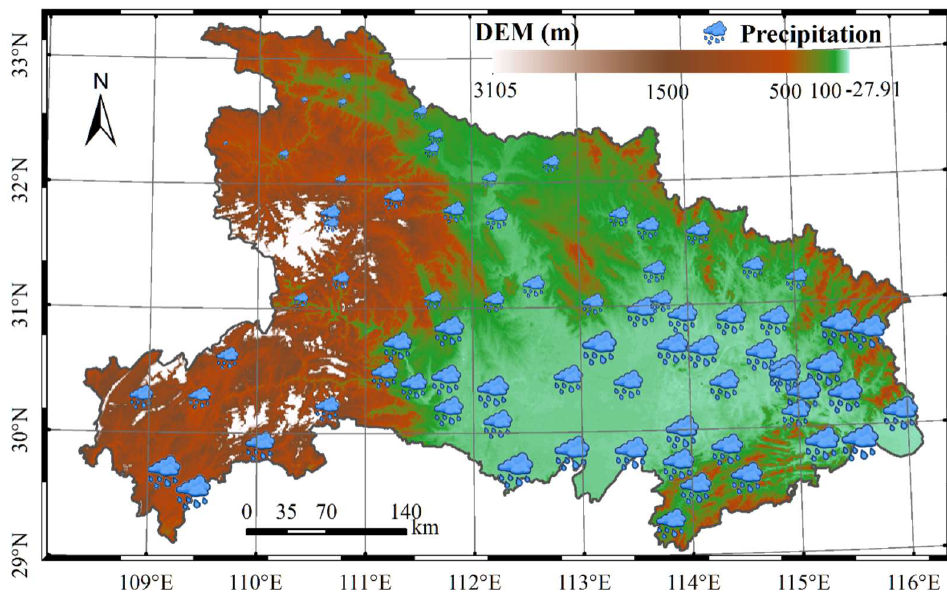
Figure 2. Distribution of topography, meteorological stations, and precipitation in Hubei Province, China.